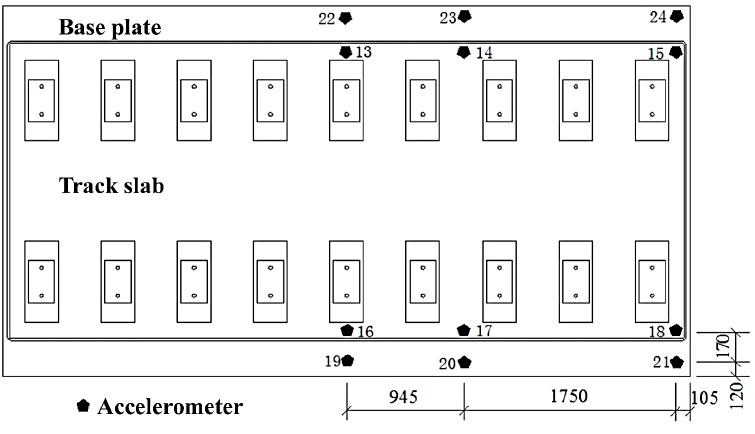
Figure 5. Sensor floor plan.